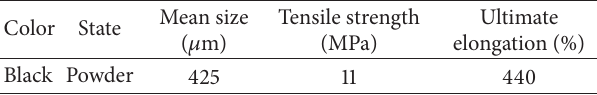
Table 1: Physical properties of waste tire-rubber powder.